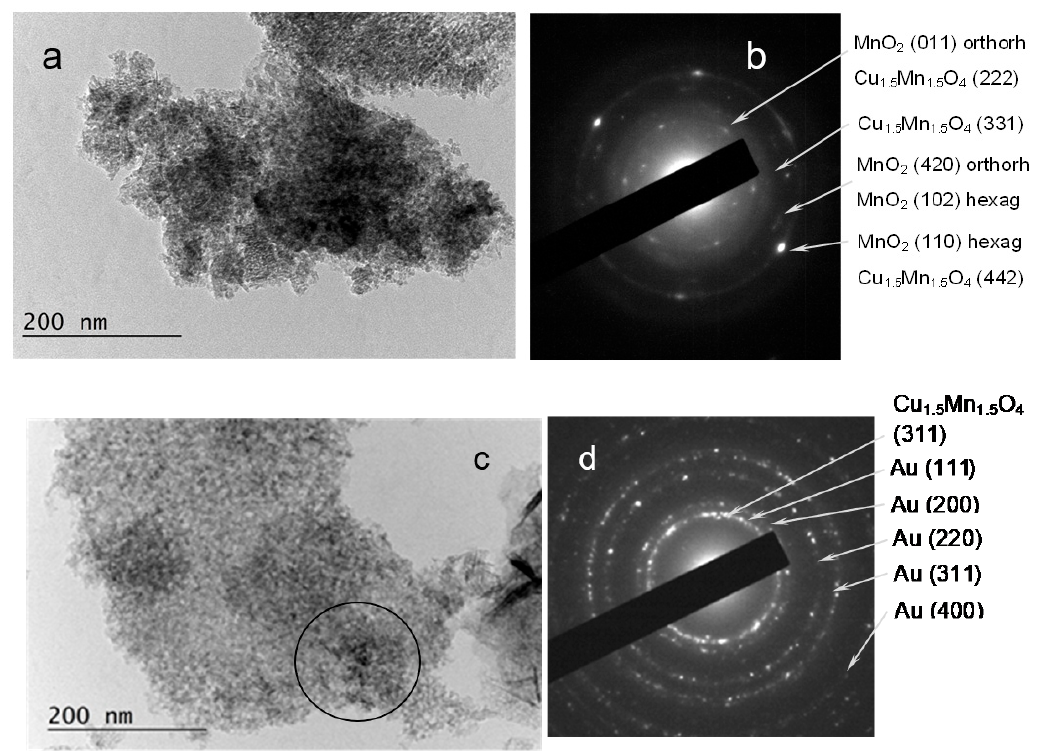
Figure 5. The TEM micrographs of fresh Au/CuMn (1:5) catalyst at a magnification of 40,000× ( a , c ) and the related SAED patterns indicating the presence of Cu 1.5 Mn 1.5 O 4 ( b ) and Au ( d